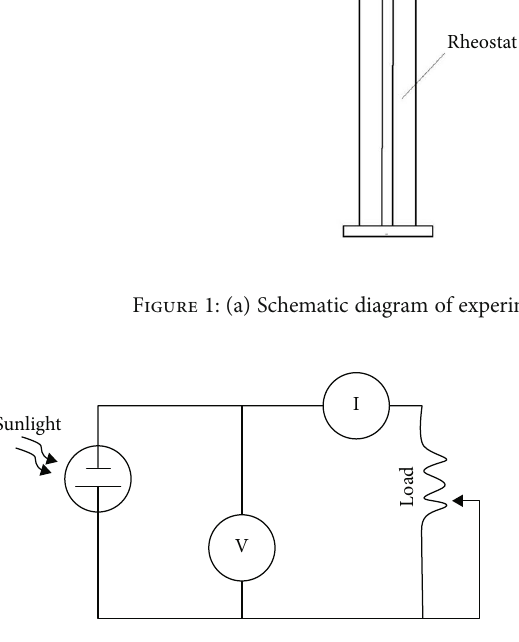
Figure 2: Electrical circuit for measuring V ‐ I